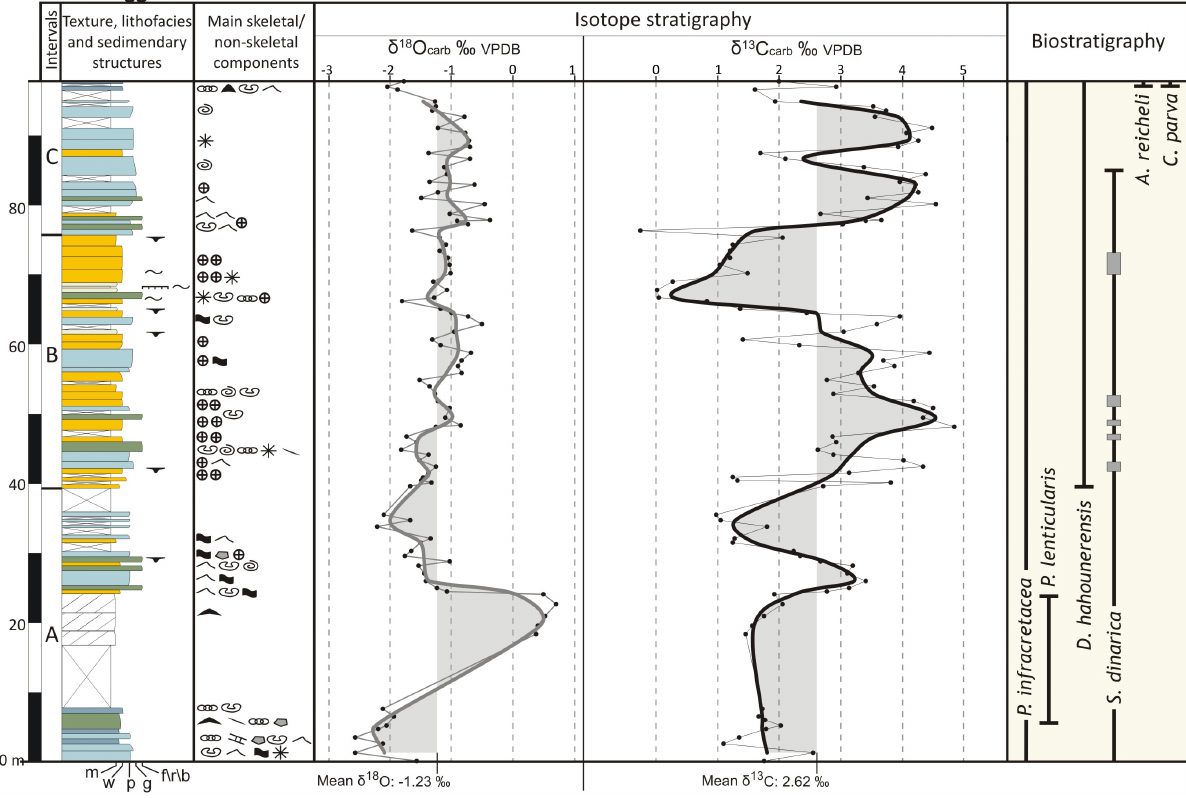
Fig. 9. Mt. Raggeto section: lithological–sedimentological log, isotope stratigraphy and biostratigraphy. The thick curves represent the 3-point moving averages of O- (grey) and C-isotope ratios (black). See Fig. 8 for a key to colours, patterns and